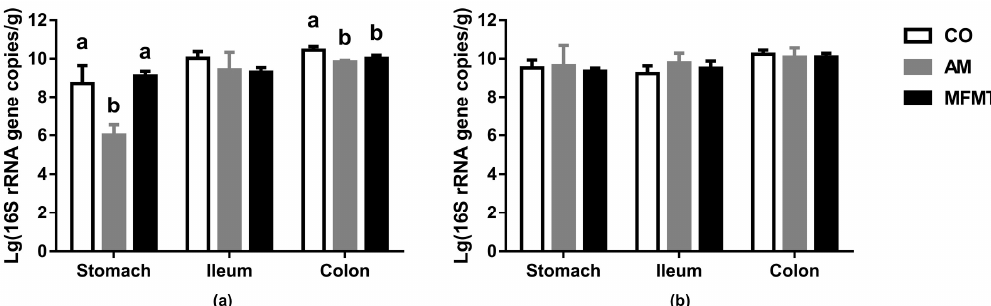
Figure 3. Total bacteria number in the stomach, ileum, and colon of piglets in the maternal fecal microbiota transplantation (MFMT), amoxicillin (AM), and control (CO) groups on days 7 ( a ) and 21 ( b ). Mean values of each gastrointestinal segment with different superscript letters (a, b) differ significantly ( p < 0.05).